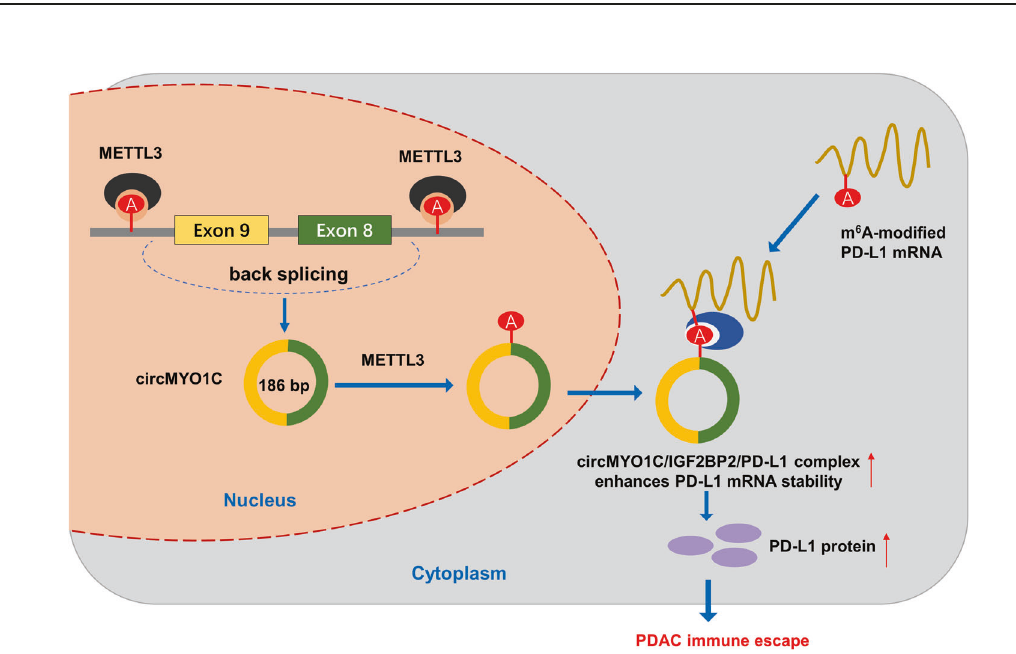
Fig. 6 circMYO1C knockdown repressed the tumor growth in vivo. A Mice were injected with short hairpin RNA (shRNA-circMYO1C) stable transfection or control groups. Tumor weight was recorded after the mice sacri fi ce. B Tumor volume was recorded every three days and calculated using the formula (0.52 × length × width × width). C Immunohistochemical staining (IHC) for PD-L1 was performed using the in vivo tissue. D Moreover, the PDAC cells were transfected with fi re fl y luciferase-labeled vectors. The anesthetic mice were monitored using bioluminescence in vivo imaging system. E CCK-8 viability assay was performed using PANC-1 cells transfected with PD-L1 overexpression (PD-L1) and circMYO1C knockdown (sh-circMYO1C-1) or IGF2BP2 silencing (si-IGF2BP2). F Transwell migration assay was performed using PANC-1 cells transfected with PD-L1 overexpression (PD-L1) and circMYO1C knockdown (sh-circMYO1C-1) or IGF2BP2 silencing (si-IGF2BP2). * p < 0.05 and ** p <